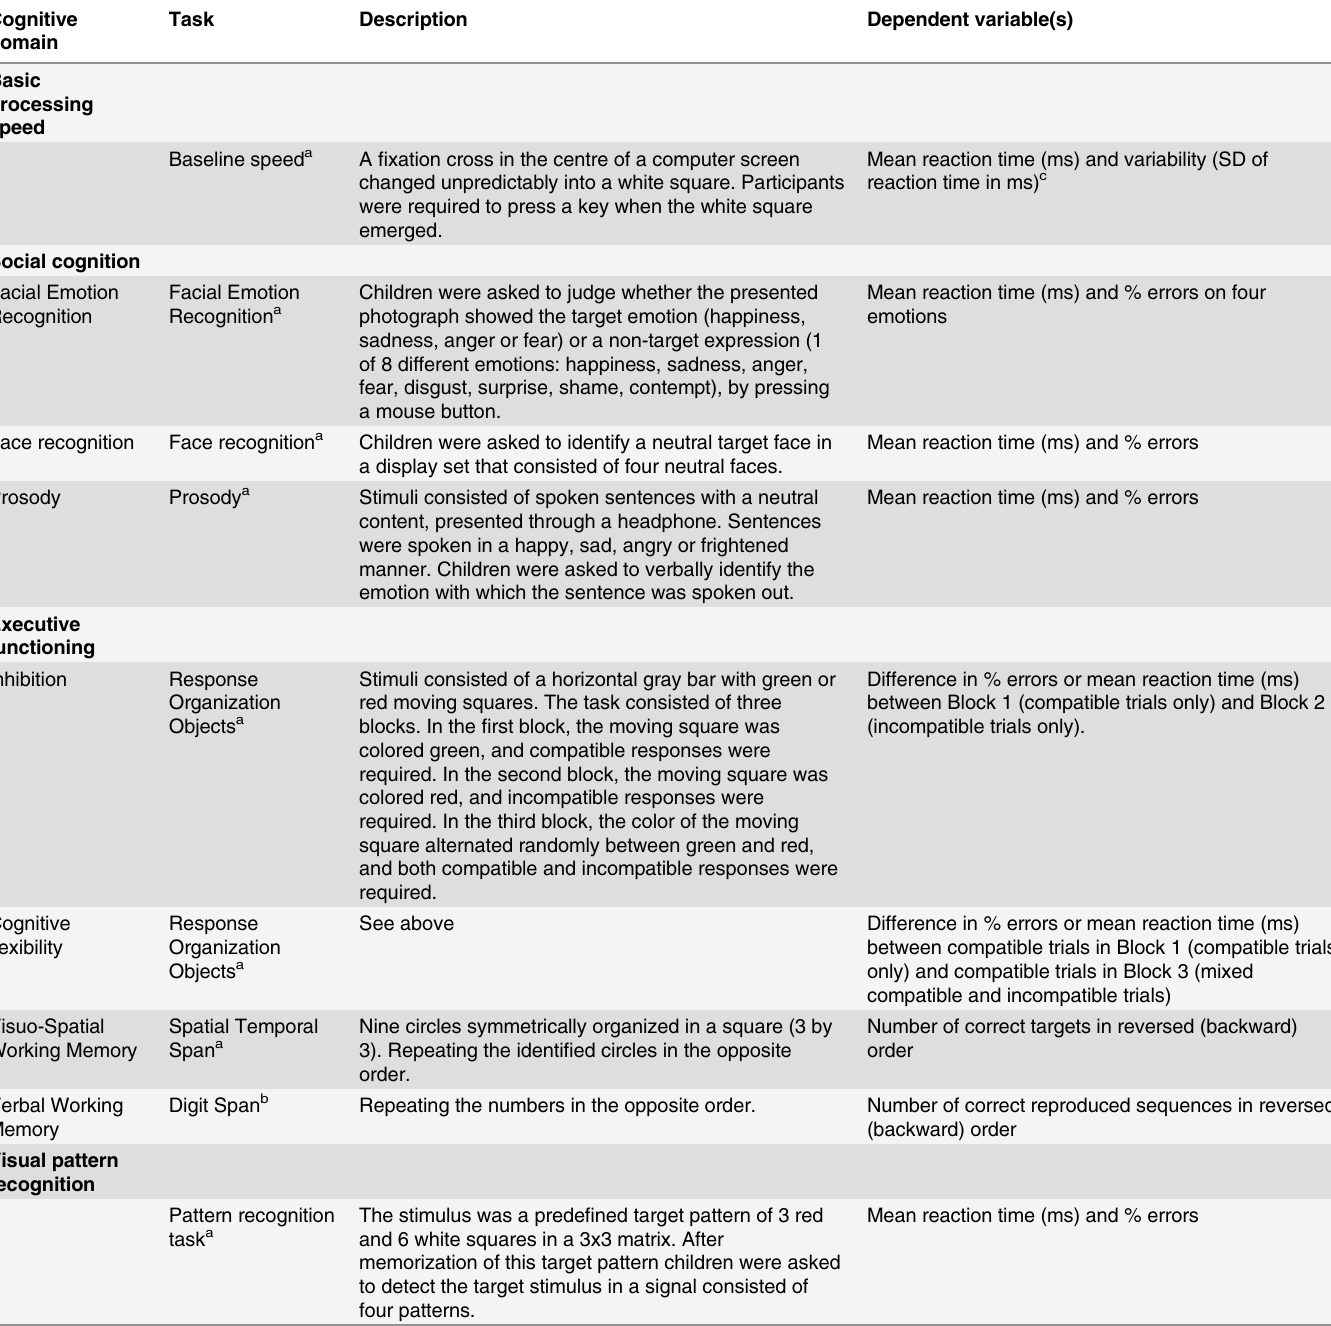
Table 2. Description of the cognitive